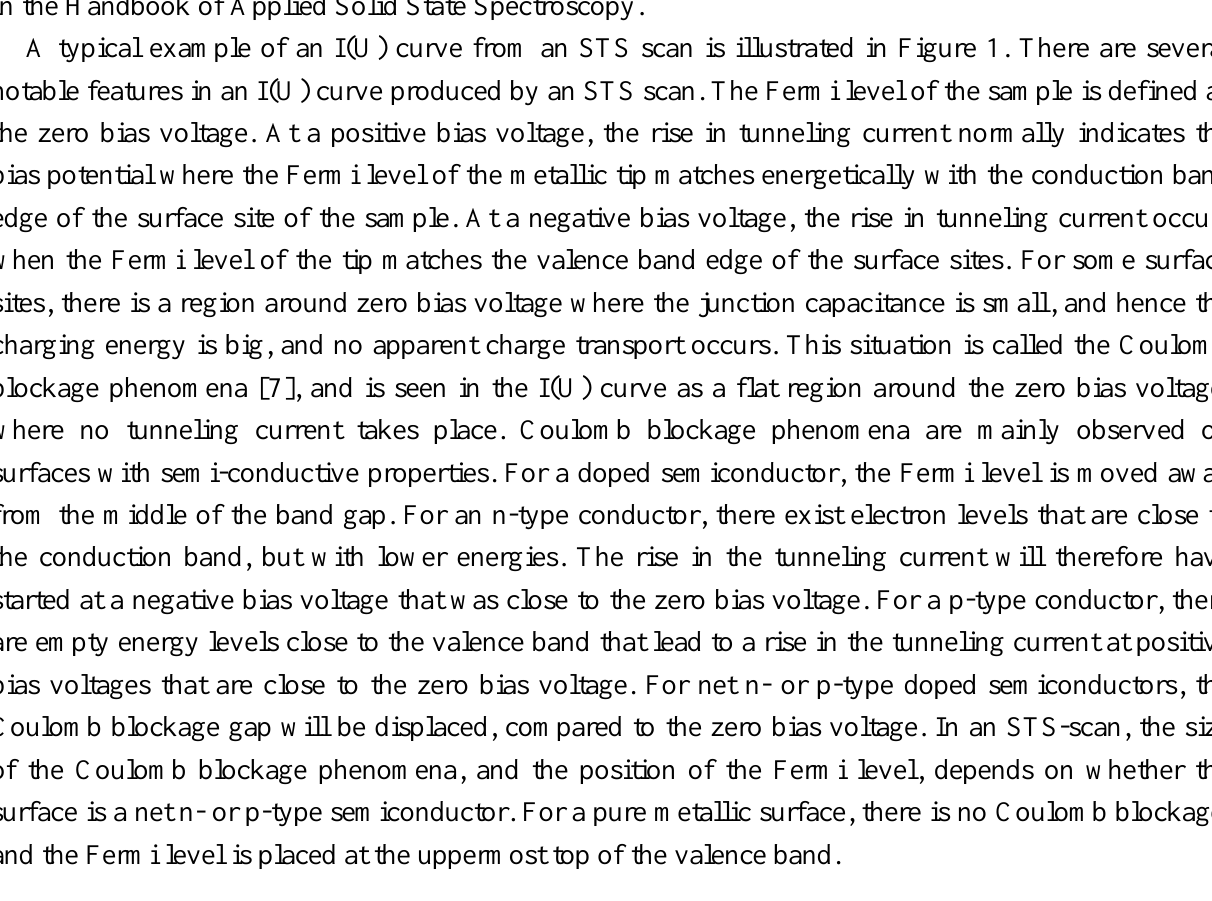
Figure 1. An example of an I(U) curve in STS. The absolute value of the tunneling current is used. The marked areas A and A are proportional with the charge amount transferred 1 2 from sample to tip and from tip to sample, respectively. Scan rate: 0.002